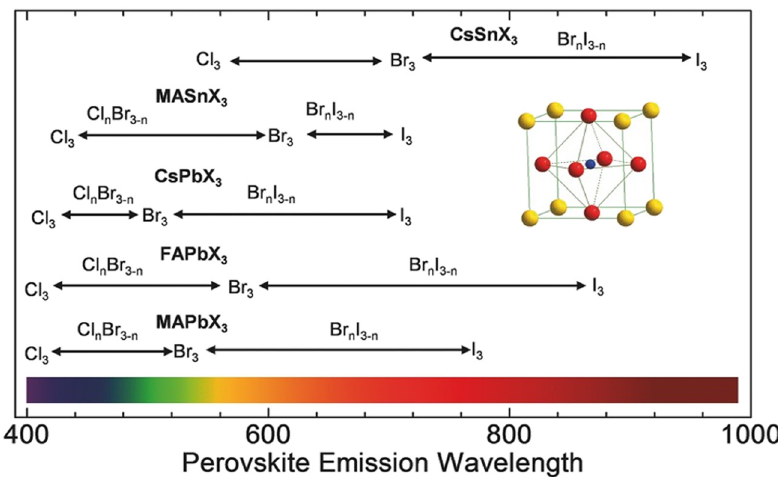
Figure 6: Spectral absorption and emission ranges of di ff erent perovskite materials in the visible light region, reproduced with permission from ref. [ 82 ] . Copyright 2017, Wiley -